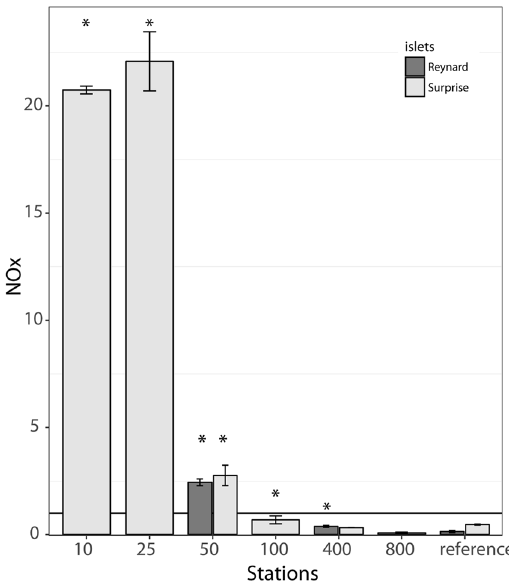
Figure 3. NOx concentrations (nitrates + nitrites) from Chesterfield (Reynard islet) and D’Entrecasteaux reefs (Surprise islet) in µ mol/L. The black line indicates the average NOx concentration at Sainte Marie (Nouméa), a station with high anthropogenic inputs. Stars denote significantly higher values compared to the reference station at a 0.05 significance level.